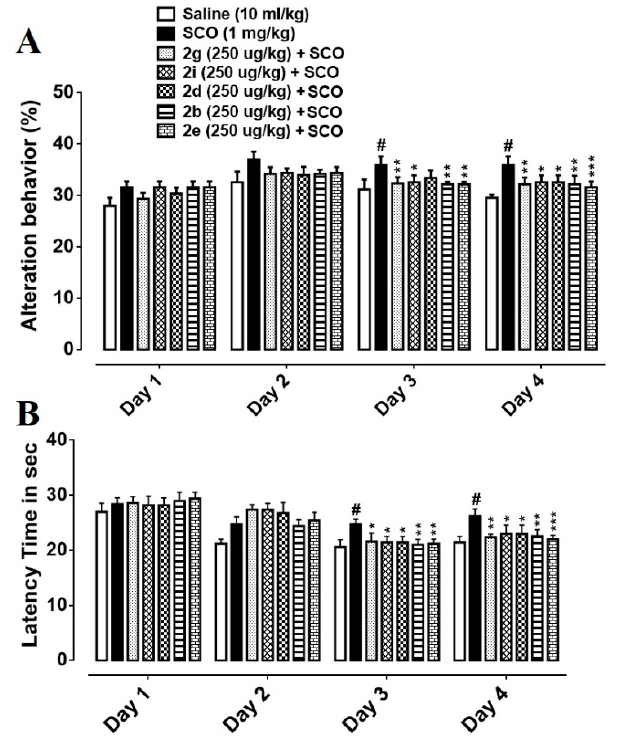
Figure 5. ( A ) % alteration behavior. Data were analyzed by mean±SEM with ( n = 10). # denotes a significant difference against the saline group; *, **, *** show significant difference against the scopolamine (SCO) group. P <0.05 is considered to be significant. ( B ) Average escape latency time. Mean±SEM for the mice ( n = 10). # denotes a significant difference against the saline group; *, **, *** show significant difference against the scopolamine (SCO) group. P <0.05 is considered to be